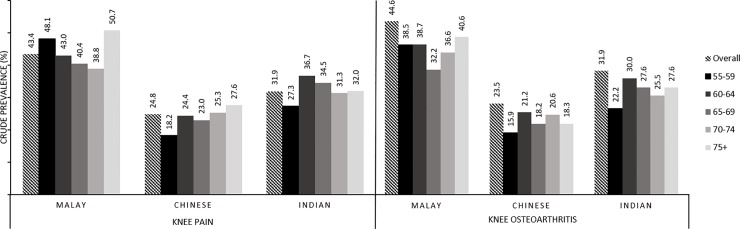
Overall crude prevalence of knee pain and knee osteoarthritis by ethnicity according to age group.